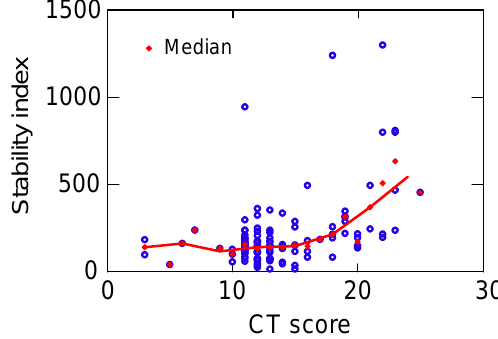
Figure 3. Stability index vs. CT score (eight cases with CT score 35 (no fracture) not shown, N = 121); moving average smoothing line between median